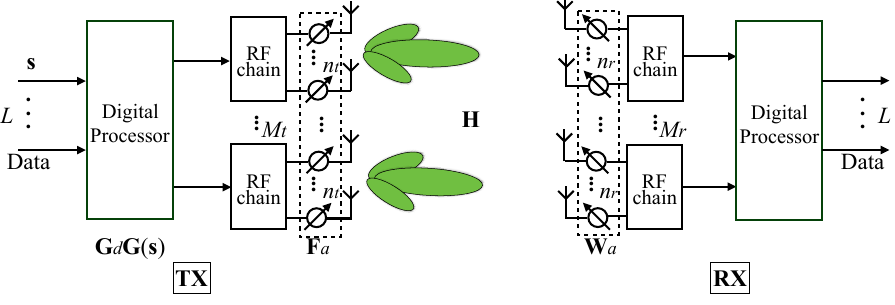
Figure 2. The diagram of hybrid beamforming in the mmWave communication